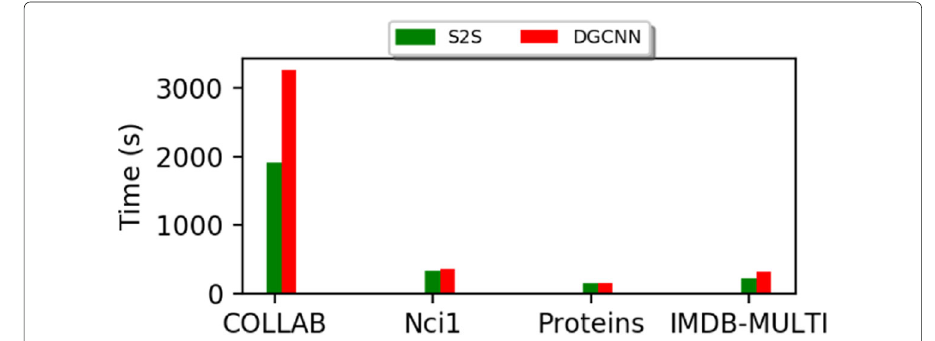
Fig. 13 Training time of graph embedding